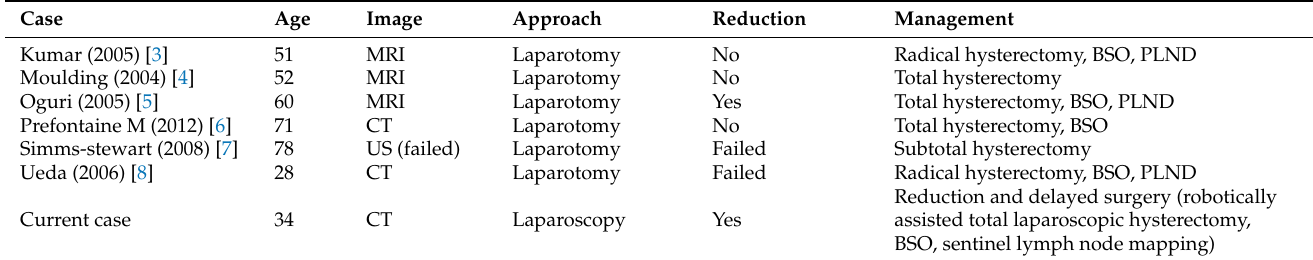
Table 1. Previously reported cases of uterine inversion associated with endometrial carcinoma.